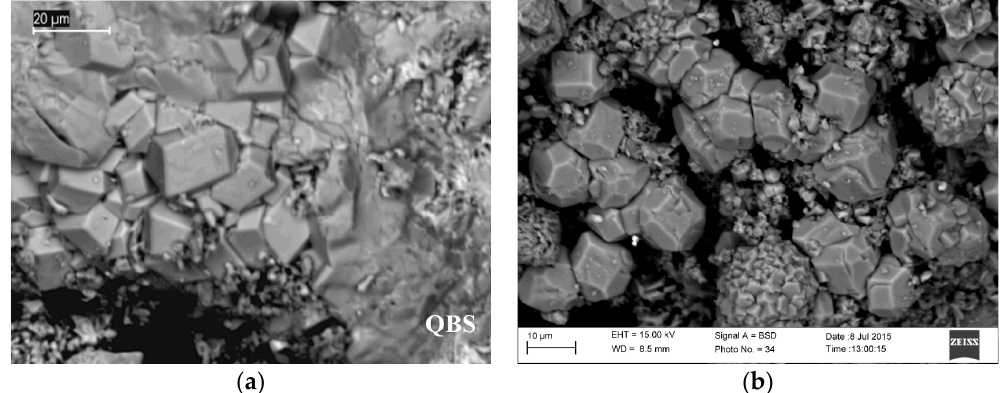
Figure 1. ( a ) SEM image of the crystals of verneite in association with fine-grained jakobssonite in the cotype sample from Eldfell. ( b ) SEM image of verneite crystals from the Vesuvius sample.